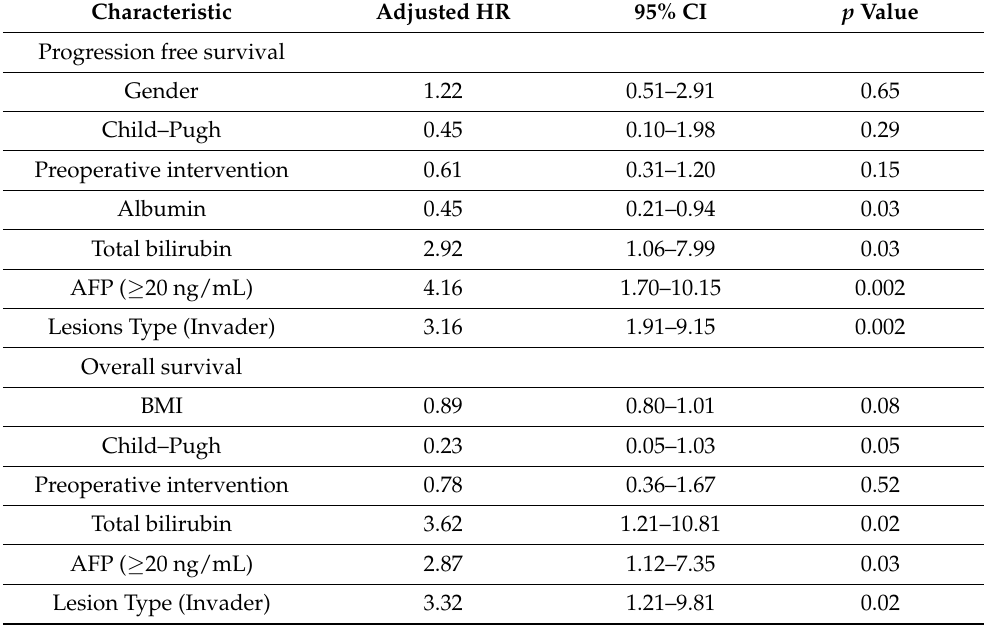
Table 5 lists the independent predictors of PFS and OS determined by multivariate Cox proportional hazards model. Again, increasing albumin had a protective effect for PFS (HR 0.45, 95% CI 0.21–0.94, p = 0.03), where a single-unit increase in preoperative albumin was associated with a 55% less chance of experiencing progression. Next, an increase in pre- operative total bilirubin (HR 2.92, 95% CI 1.06–7.99, p = 0.04) and AFP values ≥ 20 ng/mL (HR 4.15, 95% CI 1.71–10.15, p = 0.002) demonstrate increased probability of experiencing progression. Furthermore, increasing preoperative total bilirubin and AFP ≥ 20 ng/mL were also independent predictors of OS (total bilirubin HR 3.62, 95% CI 1.21–10.81, p = 0.02 and AFP ≥ 20 ng/mL HR 2.87, 95% CI 1.12–7.35, p = 0.03). Table 5. Independent predictors of PFS and OS Cox multivariate